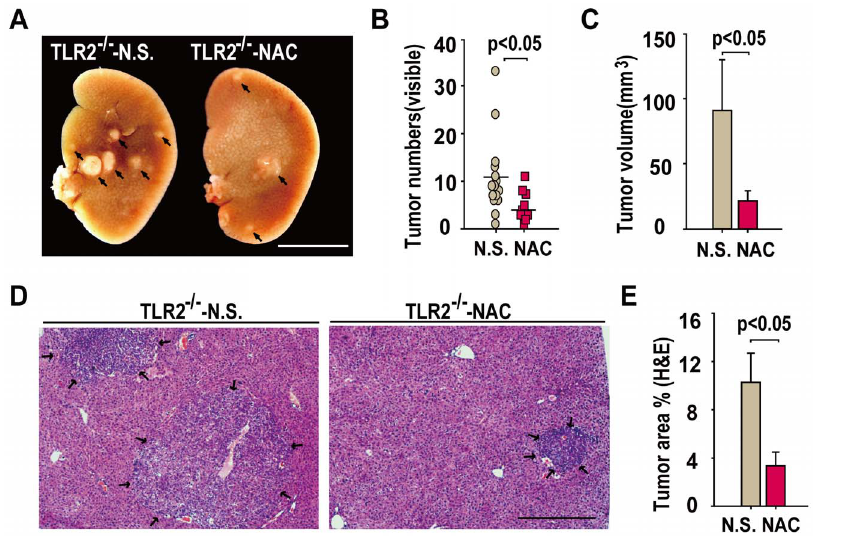
Figure 4. Antioxidant NAC ameliorates TLR2 2 / 2 -aggravated HCC progression. (A) Representative images of gross liver specimens from TLR2 2 / 2 mice treated with or without NAC at six months post-DEN injection. Scale bars, 1 cm. (B) NAC treatment decreased the number of surface tumor nodules in TLR2 2 / 2 mice. Each dot represents the tumor nodules from each mouse. Scale bars indicate the mean 6 SD (n=20 per group). (C) NAC treatment decreased the volume of surface tumors. Data are presented as mean 6 SD (n=20 per group). (D) Representative H&E stained liver sections from TLR2 2 / 2 mice treated with or without NAC. Scale bar, 500 m m. (E) The calculated tumor area (percentage of liver) is presented as mean 6 SD (n=20 per group).